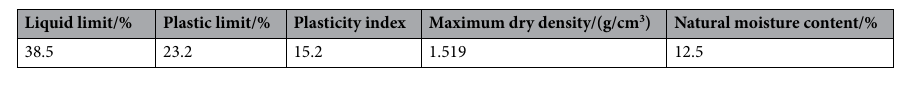
Table 1. Basic parameters of soil at Zhouqiao